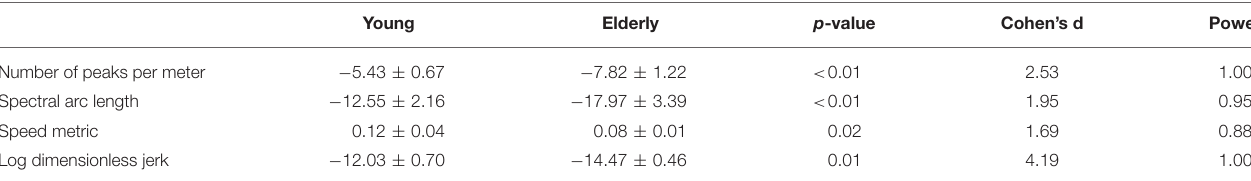
TABLE 1 | The means, standard deviations, effect-sizes, p -values, and power estimates for the young and the elderly sample for the four smoothness parameters.